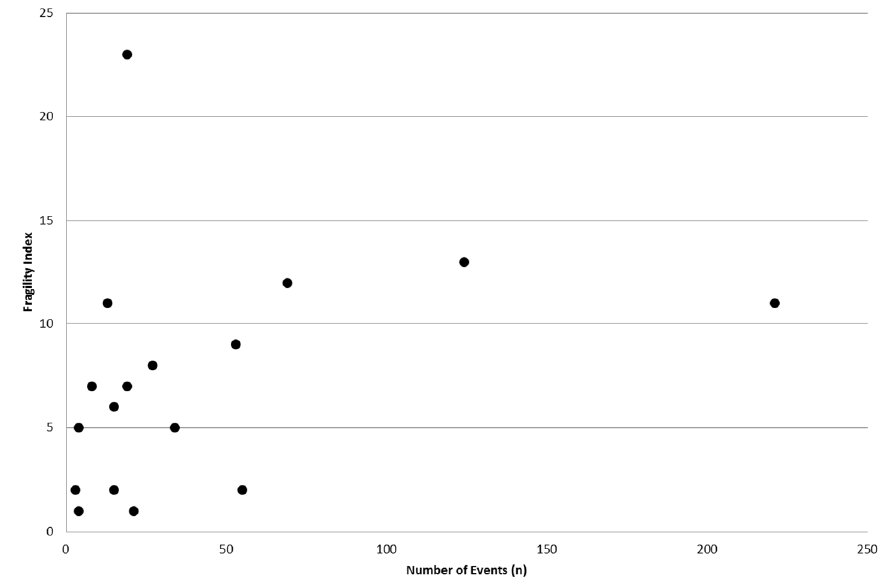
Figure 2. Correlation between RCT event number and calculated Fragility Index ( r = 0.250, p = 0.334). However, there was a strong negative correlation between the RCT p ‐ value and the Fragility Index (Figure 3).